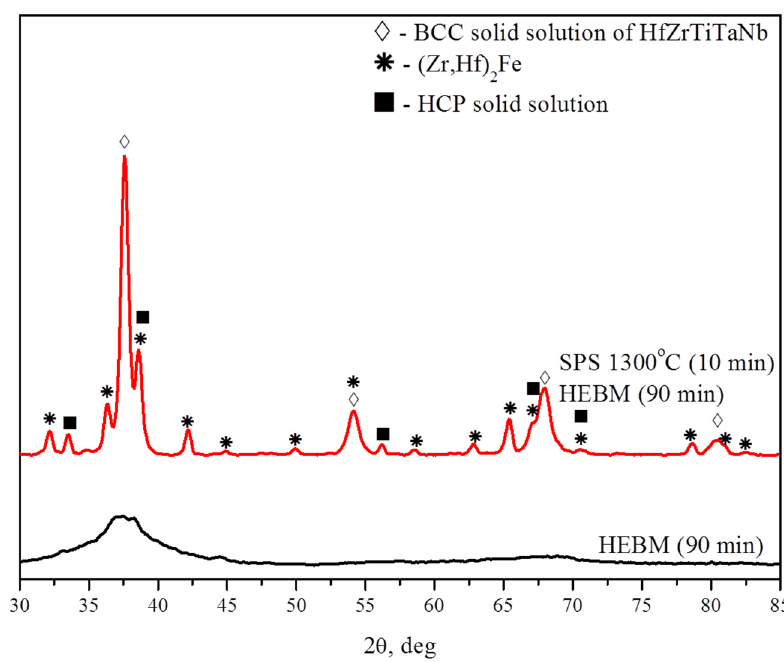
Figure 11. XRD patterns of HfTaTiNbZr powder after HEBM for t = 90 min (lower curve) and of bulk sample sintered at 1300 °C for τ = 10 min. SPS, spark plasma sintering.